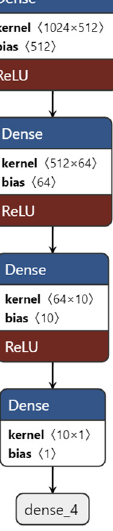
Figure 2: Neural network architecture used in this study for predicting T eff , g log , [ ] / M H , and v i sin e . These parameters are predicted with networks having the same architecture but di ff erent parameters as shown in Table 2. Explanations about the kernel and bias dimensions can be found in the study by Wu ( 2017 )